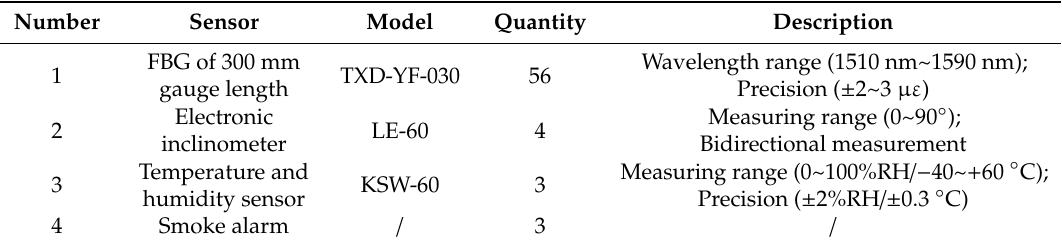
Table 2. The sensor models of the sensor